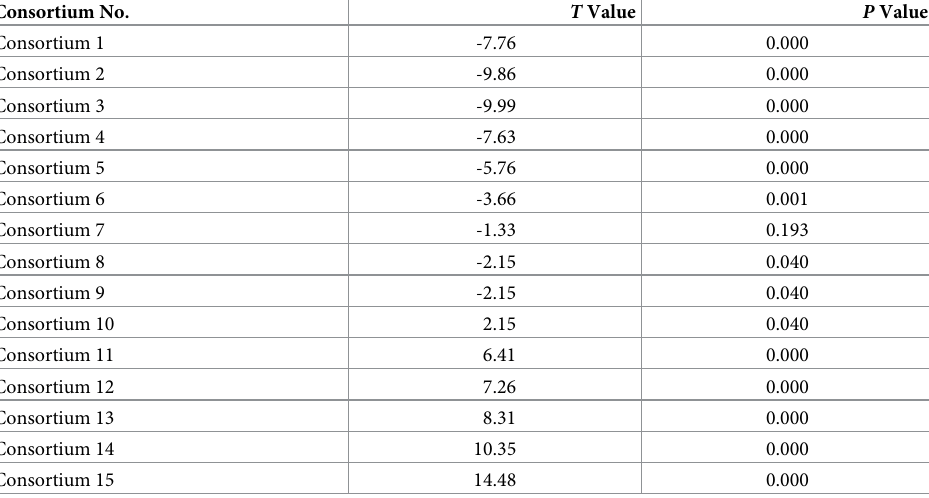
Table 7. ANOVA of fungal consortium producing lipase. Consortium